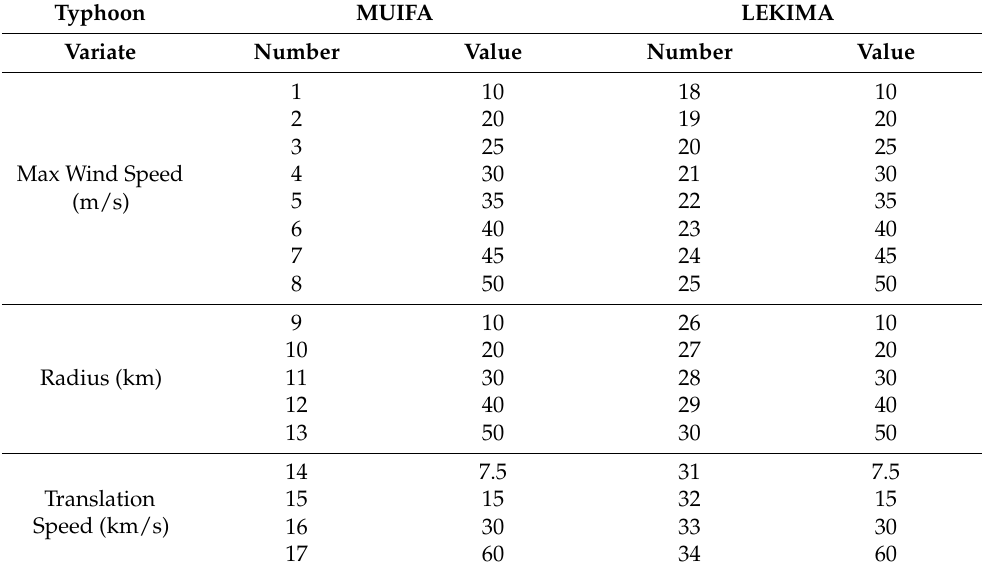
Table 2. Design of the sensitivity experiments. In each experiment, only one parameter was varied.